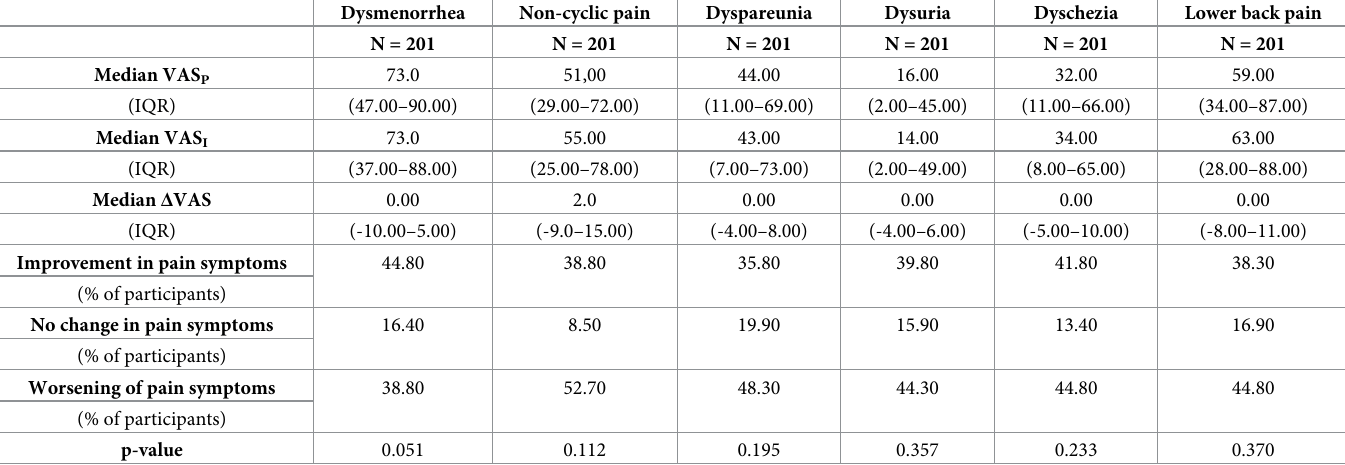
Table 3. Sensitivity analyses of differences of pain intensity ( Δ VAS) during social isolation or quarantine (VAS I ) and previous to social isolation or quarantine (VAS P ) in the group of those respondents who completed all questions regarding pain